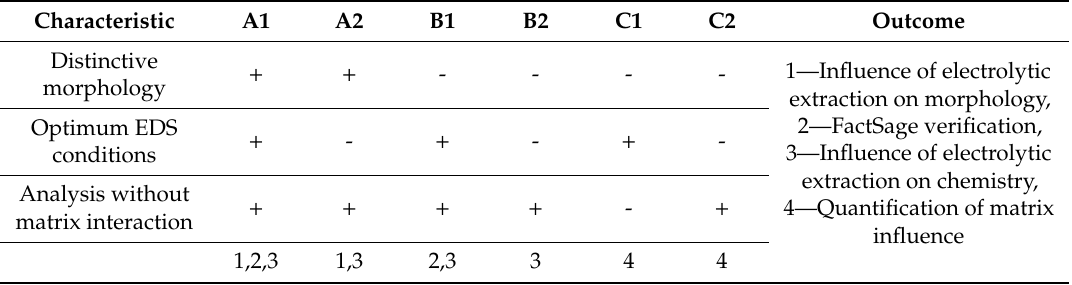
Table 3. Outcome of correlating characteristics and particle classes.